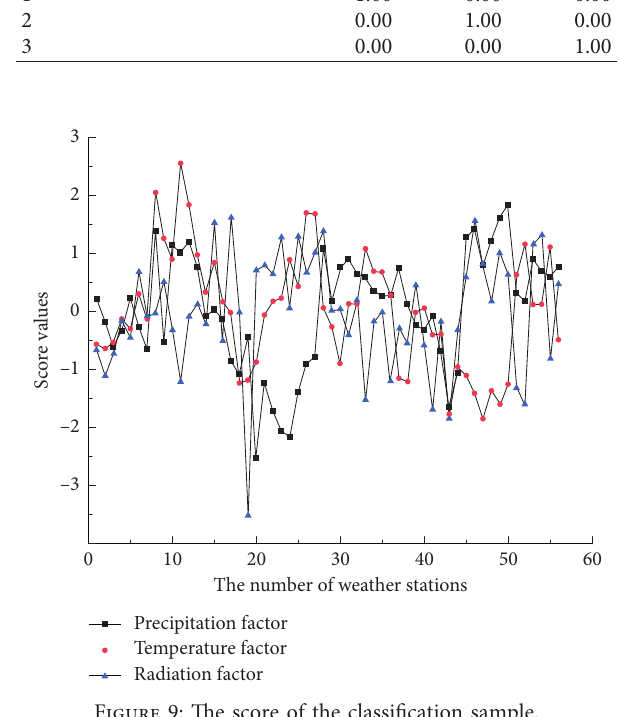
Figure 9: The score of the classification sample.